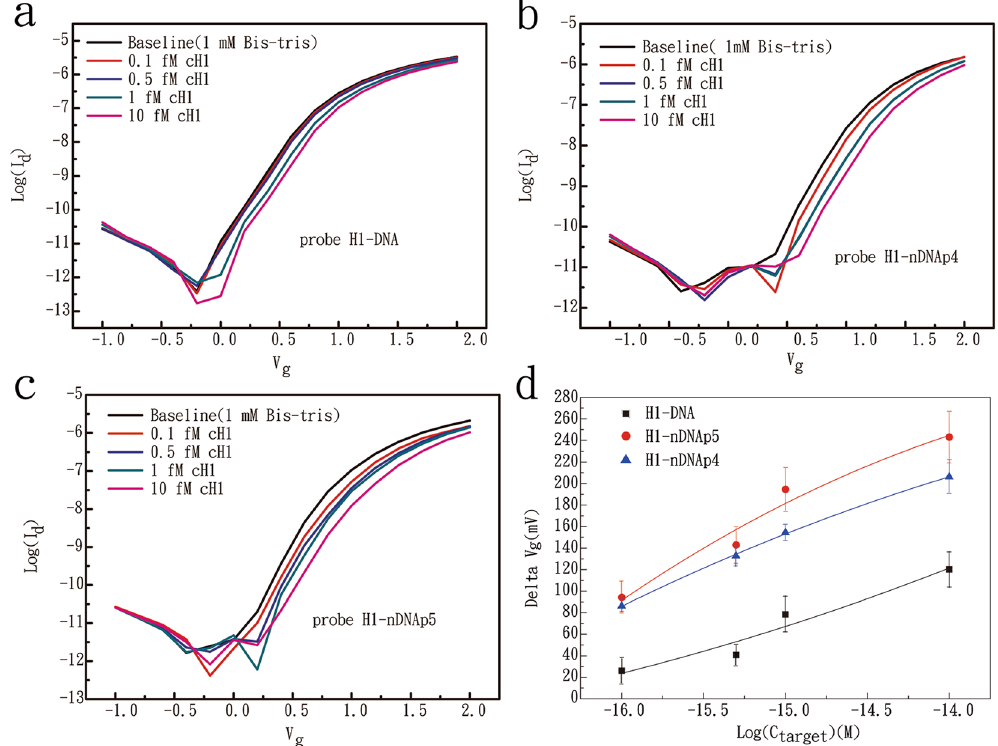
Figure 4. I–V curves for the detection of cH1 target molecules at concentrations of 10, 1, 0.5, and 0.1 fM with probes of H1-DNA ( a ), H1-nDNAp4 ( b ), and H1-nDNAp5 ( c ). ( d ) The calculated gate voltage changes of FET devices in the detection of complementary target oligomers with ultralow